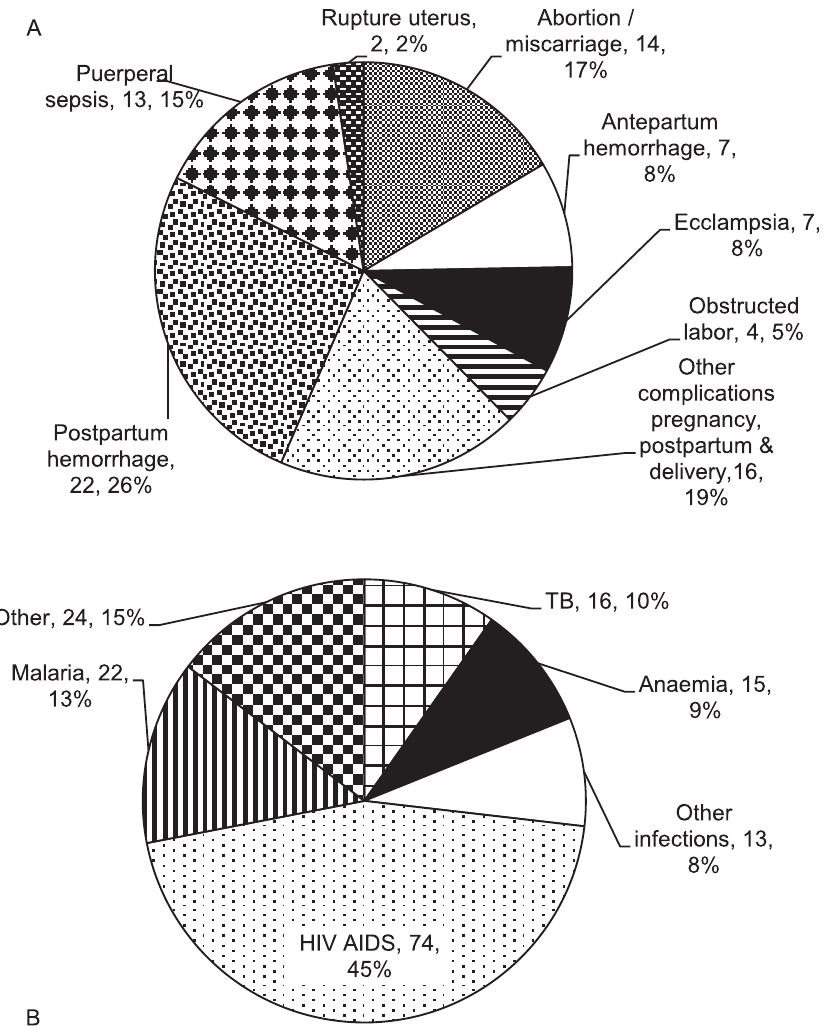
Figure 2. Classification of major causes of pregnancy-related deaths. A. Directly Ascribed Pregnancy-Related Mortality Causes B. Indirectly Ascribed Pregnancy-Related Mortality Causes.